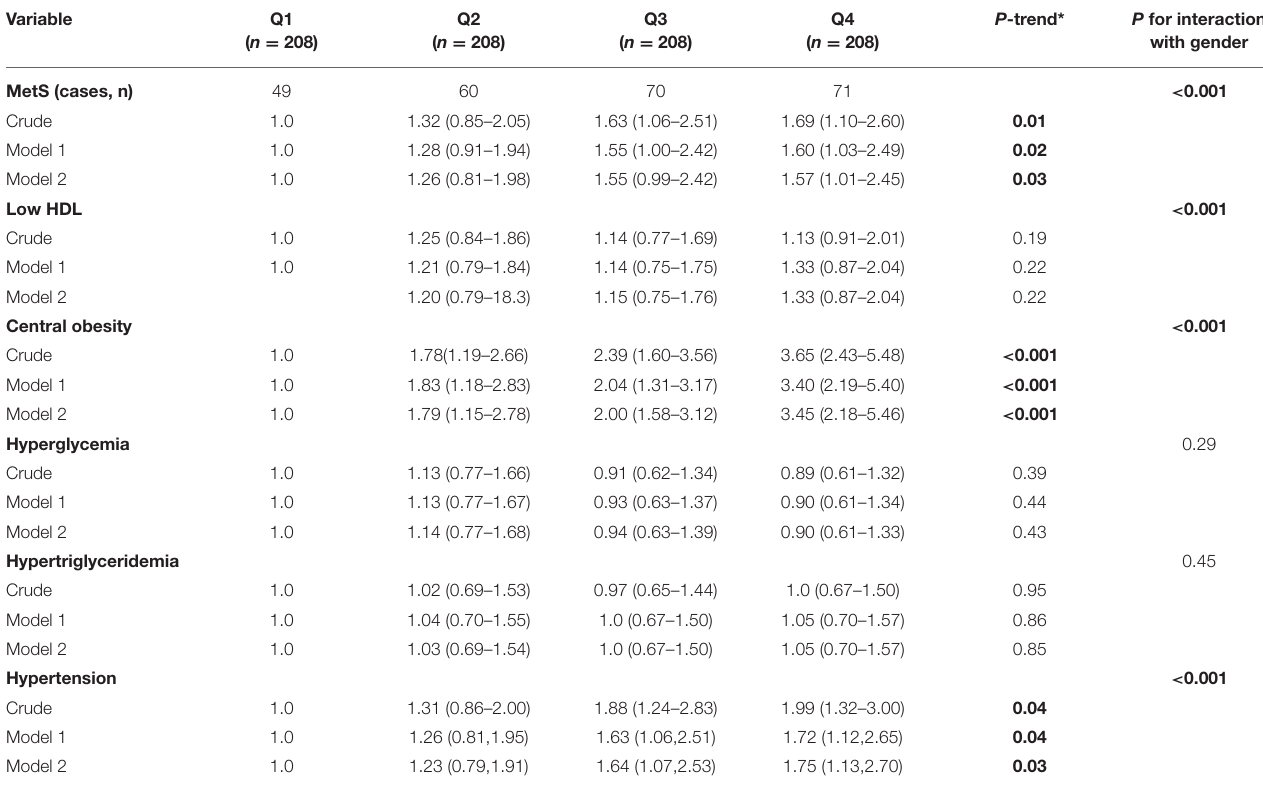
TABLE 4 | Association between the DLIS and MetS and its component in Tehranian adults (Odd ratios and 95% CI). Variable P for interaction